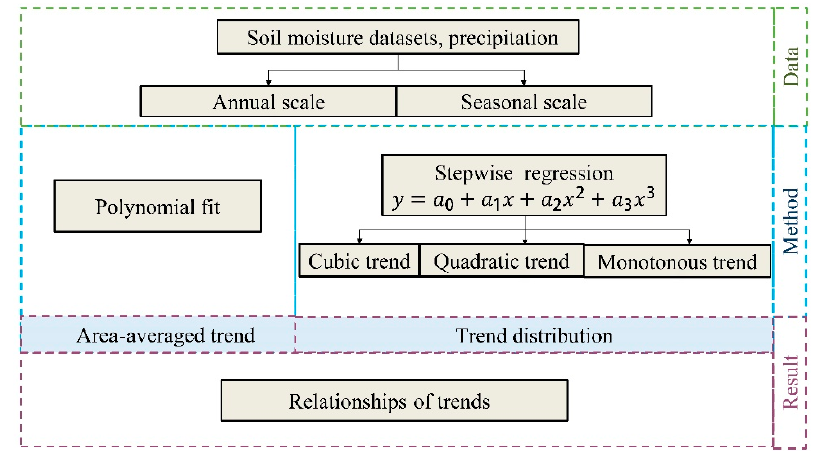
Figure 1. Brief flow scheme of trend analysis.